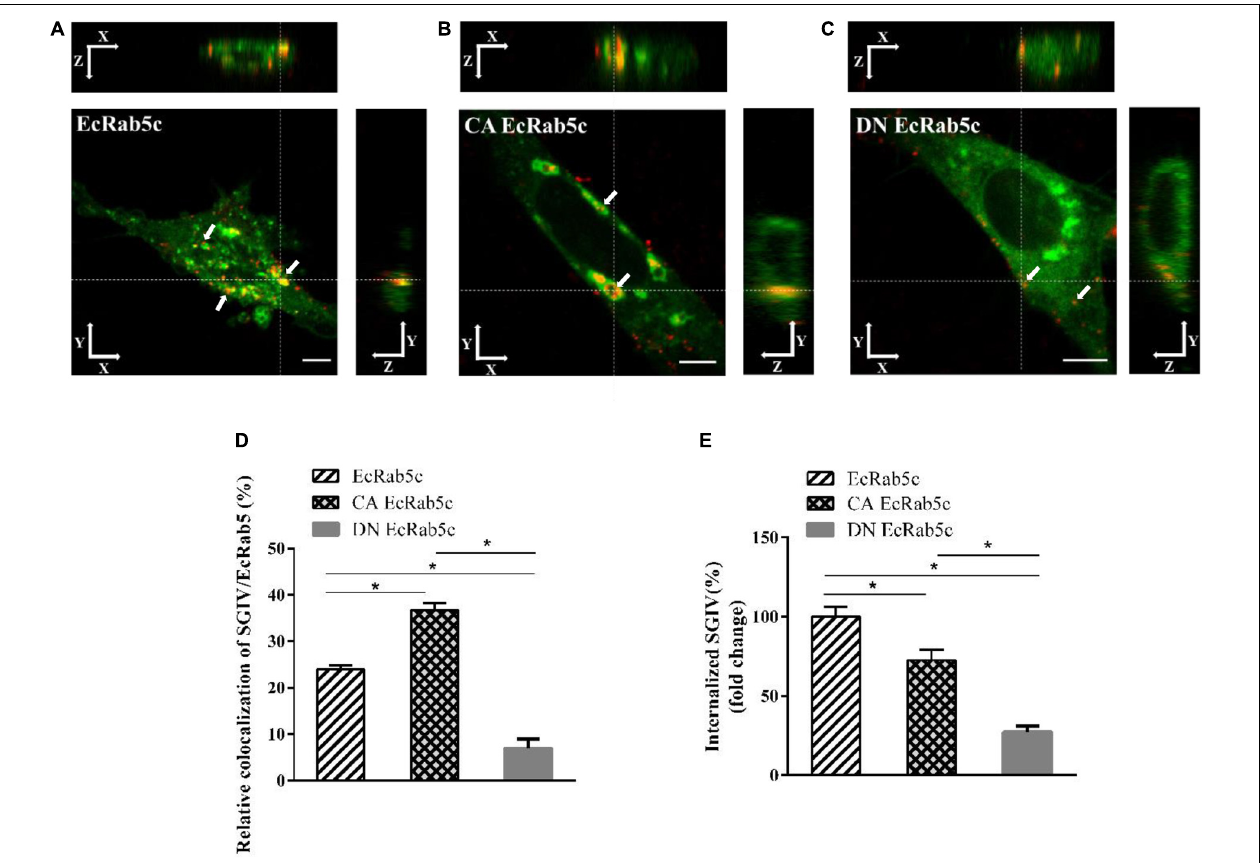
FIGURE 4 | The mutant of EcRab5c affect the transportation of SGIV. (A) The 3D images of the colocalization of SGIV and EcRab5c. GS cells transfected with pEGFP-EcRab5c (Green) were incubated with Alex-Fluor 647 labeled SGIV (red) at 4 ◦ C for 20 min, transferred to 28 ◦ C, and then were fixed at 1hpi. White arrow indicated SGIV particles. Scale bars are 5 µ m. (B) The 3D images of the colocalization of SGIV and CA EcRab5c. (C) The 3D images of the colocalization of SGIV and DN EcRab5c. (D) Quantification of SGIV particles colocalized with EcRab5c, CA EcRab5c and DN EcRab5c, respectively. Over 90 cells were randomly chose and analyzed by MATLAB program. The data are indicated as the mean ± SEM. *p < 0.05. (E) Quantification of internalized SGIV particles in EcRab5c, CA EcRab5c, or DN EcRab5c transfected cells. Over 90 cells were randomly chose and analyzed by MATLAB program. The data are indicated as the mean ± SEM. * p <